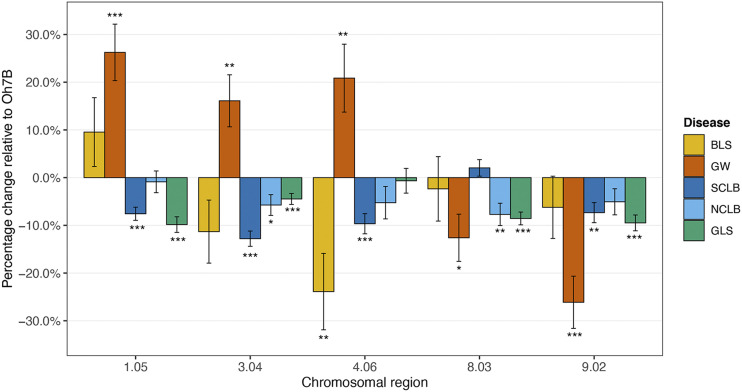
Estimation of haplotype effect. The x-axis indicates the selected genomic regions, and the y-axis indicated the percentage change of disease severity of lines with an introgression at that region. The negative percentage value indicates that lines with an introgression in this region were more resistant than Oh7B and a positive value indicates that the lines were more susceptible. A t-test was conducted to examine the significance of bin effect. * indicates the 0.05 significance level; ** indicates the 0.01 significance level and *** indicates that p-value was smaller than 0.001.